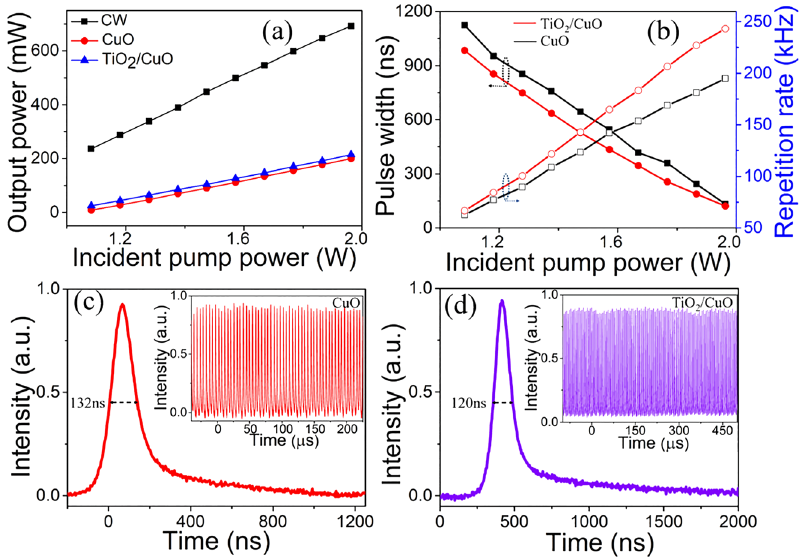
Figure 5: Experimental performances of the passively Q-switched (PQS) lasers with cupric oxide (CuO) and TiO 2 /CuO nano- composites at 1.06 μ m. (a) Continuous wave (CW) and Q-switched average output power. (b) Pulse width and repetition rate versus the incident pump power. (c), (d) Typical Q-switched temporal pulse profile and trains of CuO and TiO 2 /CuO lasers,